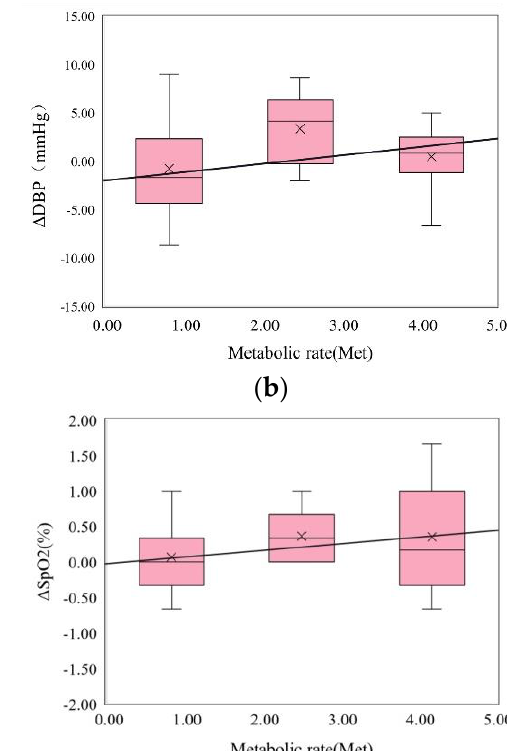
Figure 10. Relationships between TSV and HR.